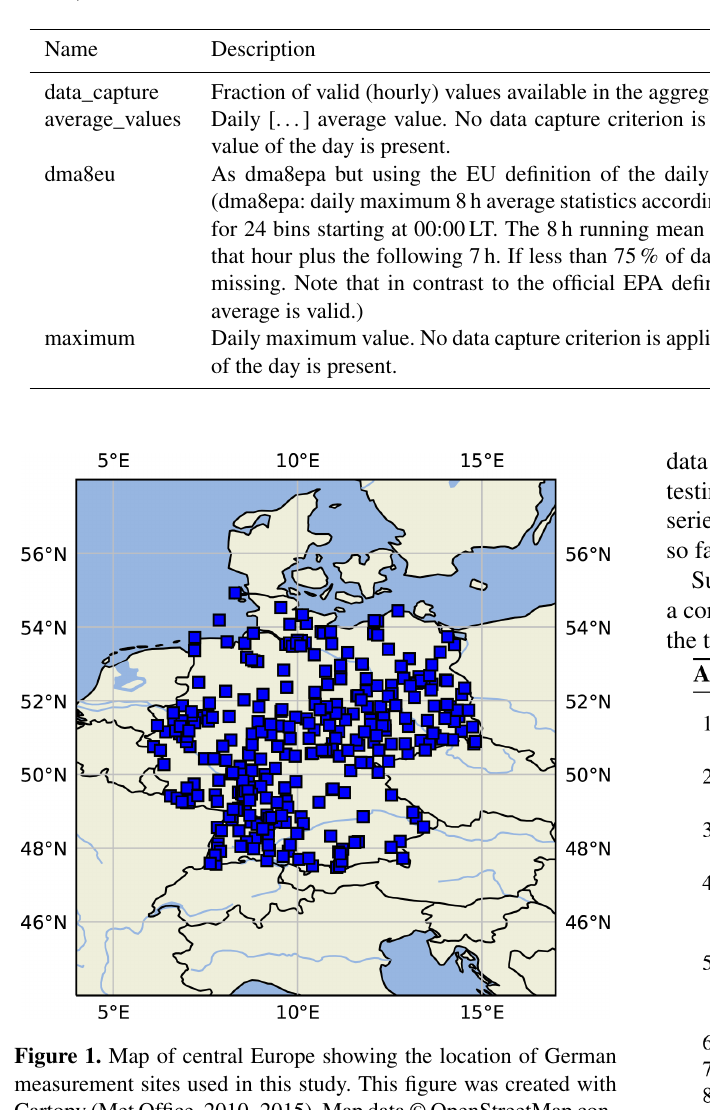
Table 3. Definitions of statistical metrics in TOAR analysis relevant for this study. Adopted form Schultz et al. (2017, Supplement 1, Table 6, therein).